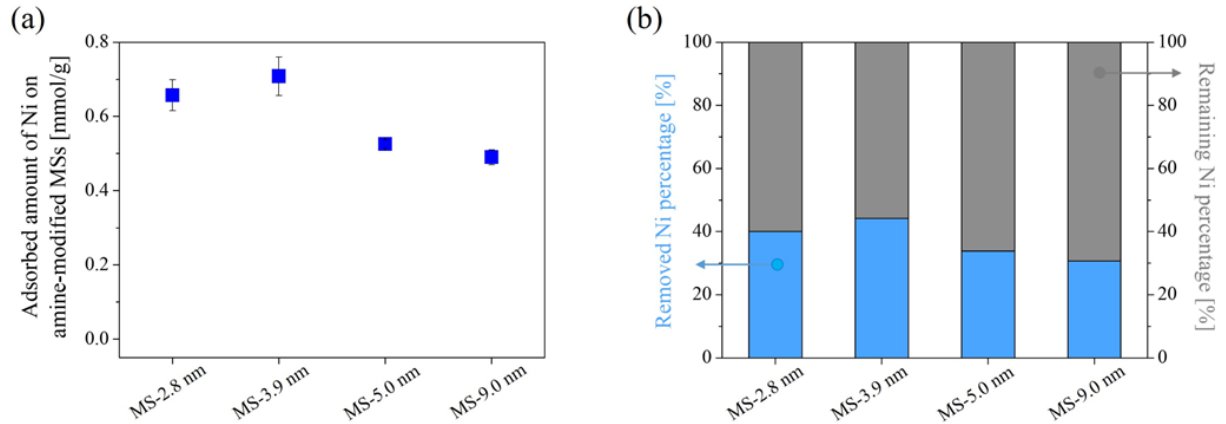
Figure 9. Ni adsorption amount on amine-modified MS with different initial MS pore sizes in a single-component system( a ) and their removed/remaining Ni percentage ( b ). Error bars indicate the standard deviation (± σ